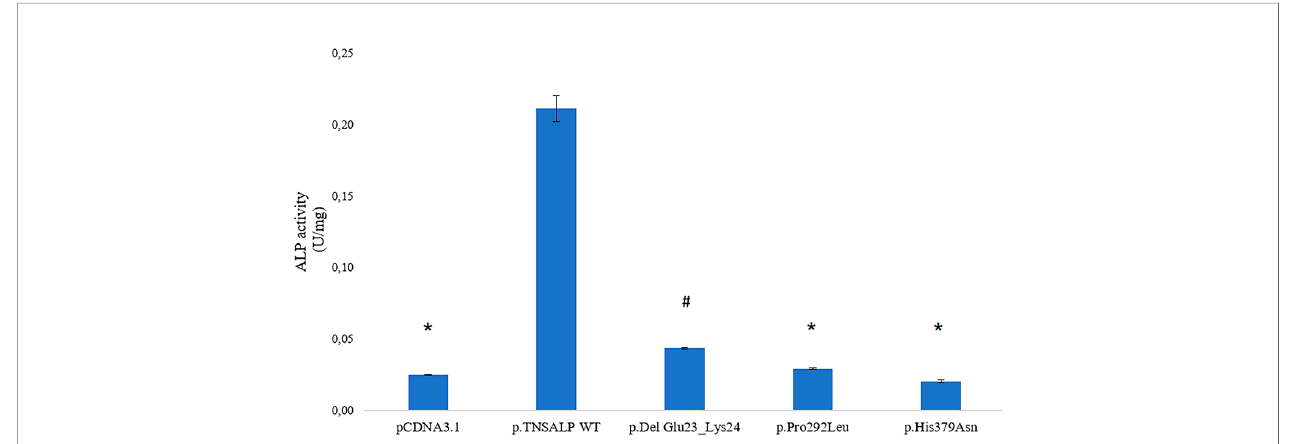
FIGURE 2 | ALP activity in HEK293T cells transfected with pcDNA 3.1 or pcDNA 3.1+ insert. Quantitative results of the ALP assay expressed in U/mg are shown. Results are expressed as mean ± SEM of TNSALP activity. ANOVA was used for comparisons between groups. * p < 0.001 vs WT; # p < 0.001 vs all